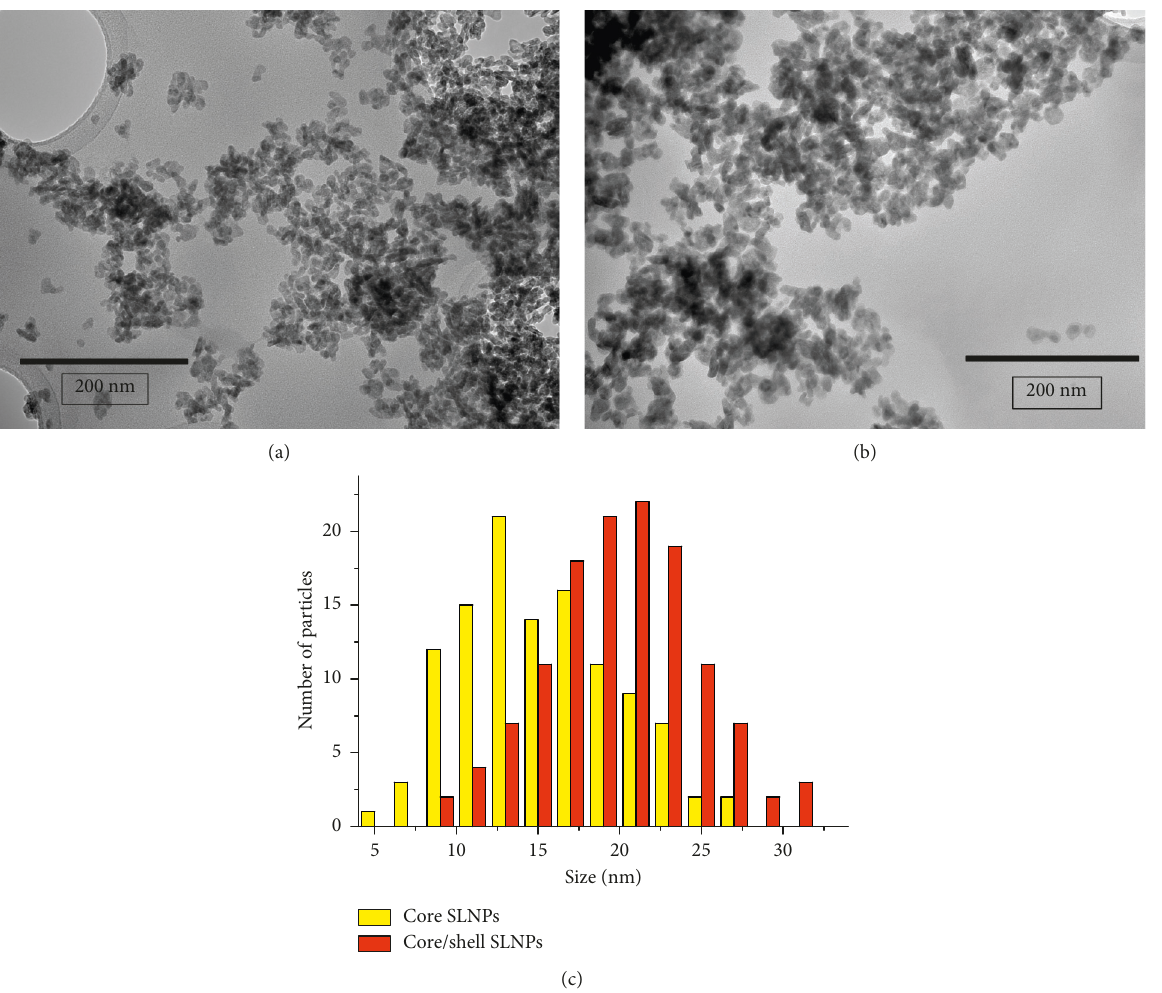
Figure 2: TEM image of (a) core nanospheres and (b) core/shell nanospheres. (c) The size distribution of core nanospheres and core/shell